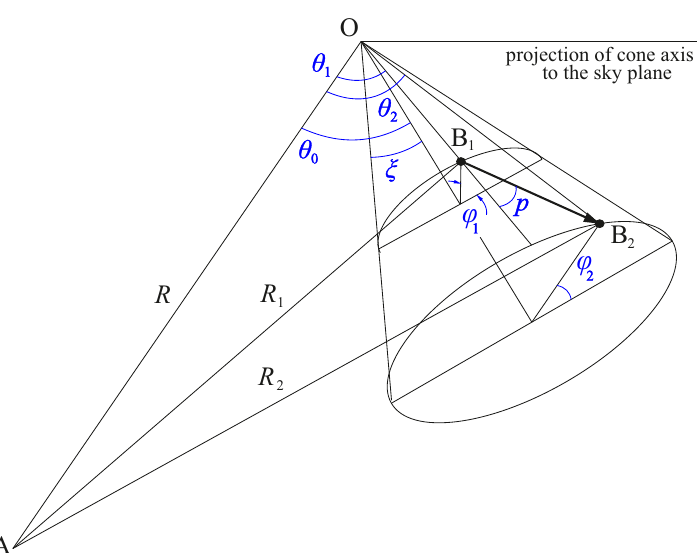
Figure A1. Scheme of a jet component motion relative to the line of